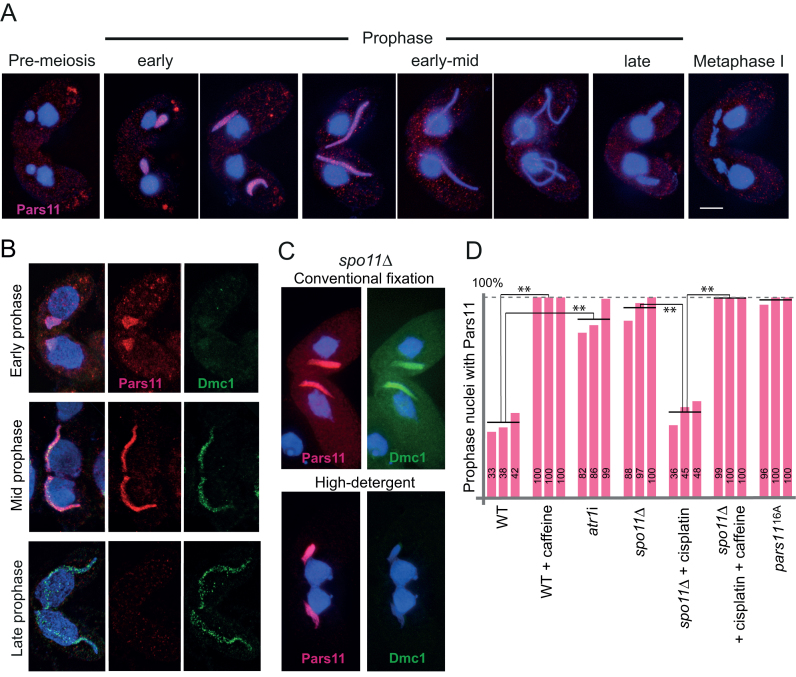
Pars11 localization. (A) Pars11 localizes to early meiotic prophase nuclei and disappears prior to full nuclear elongation. (B) Localization of Pars11-HA (red) and Dmc1 (green) to chromatin in detergent-spread nuclei in early, mid and late prophase. (C) Pars11 localizes to chromatin in spo11Δ. Pars11-HA is insensitive to high-detergent fixation, whereas Dmc1 is sensitive. Bar: 10 μm. (D) Pars11 localization to prophase nuclei is stabilized in the absence of DSBs (spo11Δ), when DSBs are not sensed (ATR depletion by caffeine or atr1i) or when Pars11 is not phosphorylated (pars1116A). Changes in nuclear Pars11 localization are significant (**P < 0.01, paired t-tests). Three biological repeats, each with at least 50 nuclei evaluated, were done for each type.